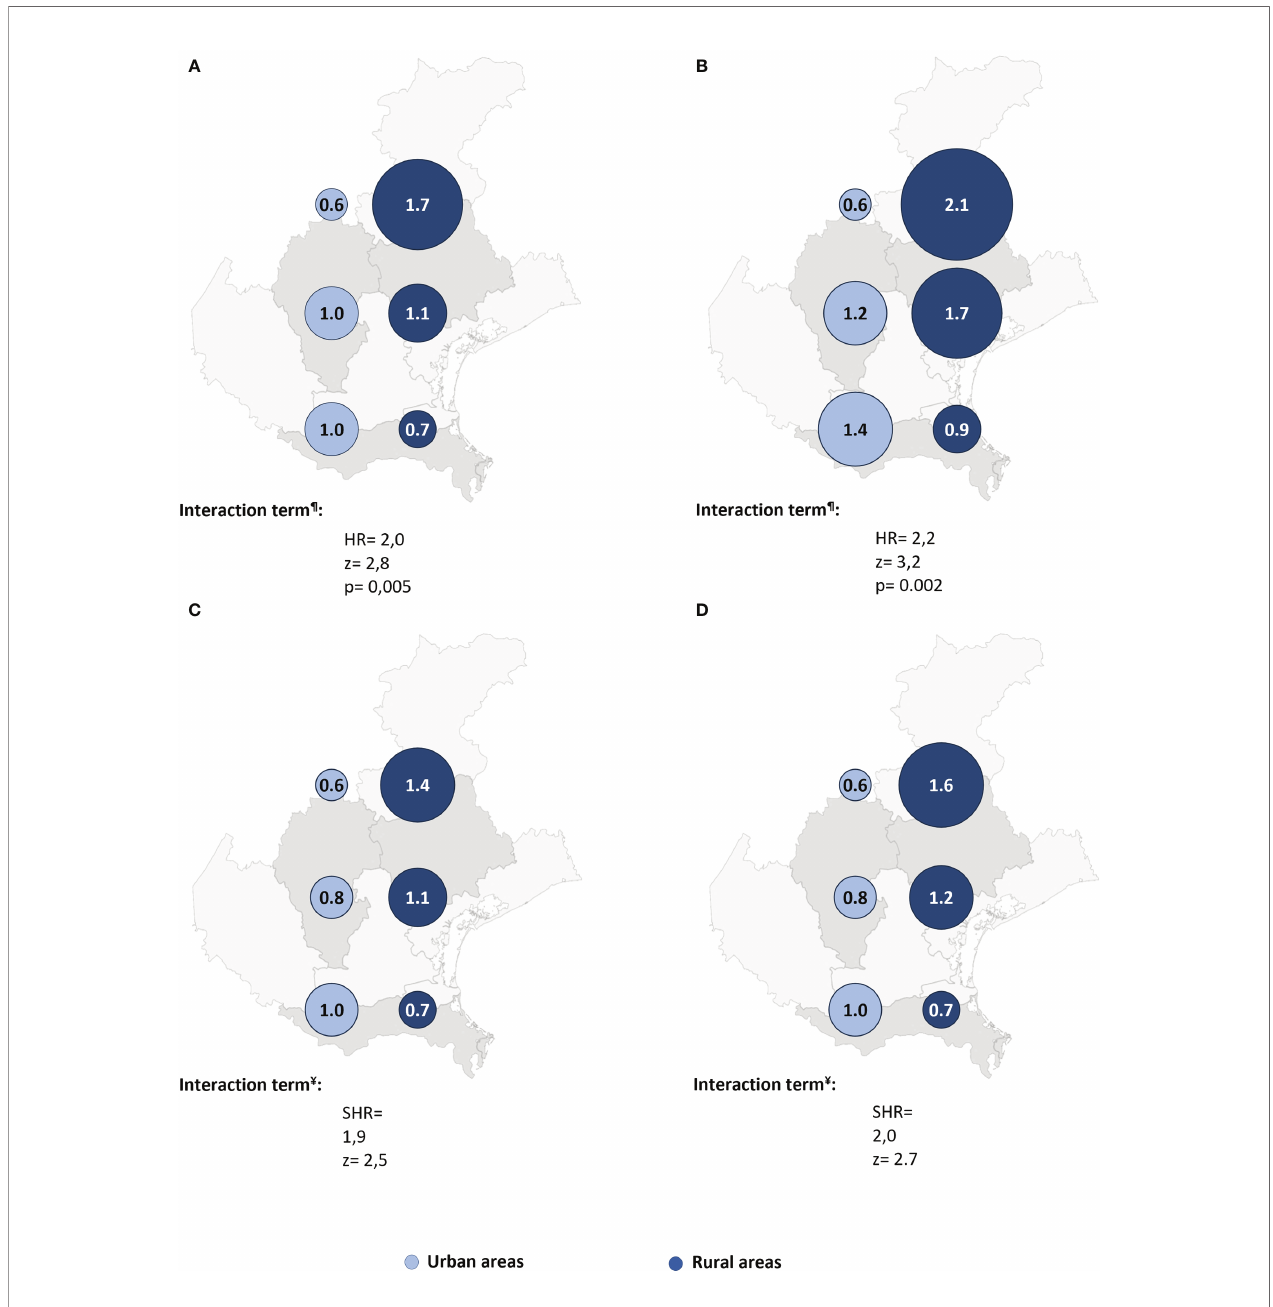
FIGURE 5 | The predicted relative hazards and sub-hazards ofneoplasticmortality 22 yearsafter acute coronary syndrome in thesix geographic areas after excluding patients whohad malignancy and still alive(n = 519 patients).SHR, Sub-hazards ratio. The relative hazards were calculated margins post estimation of the unadjusted (A) , andthe fully adjusted (B) Cox regression analysis. The relative sub-hazards were calculatedusing marginspostestimation of the unadjusted (C) , andthe fully adjusted (D) Fine-Gray competing risk regression analysis. ¶ Calculated using Cox regression analysis. ¥ Calculated usingFine-Gray competing risk regression